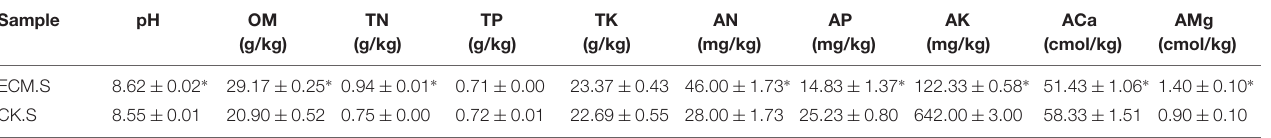
TABLE 2 | Properties of the Quercus aliena rhizosphere and the ectomycorrhizosphere soil. Sample